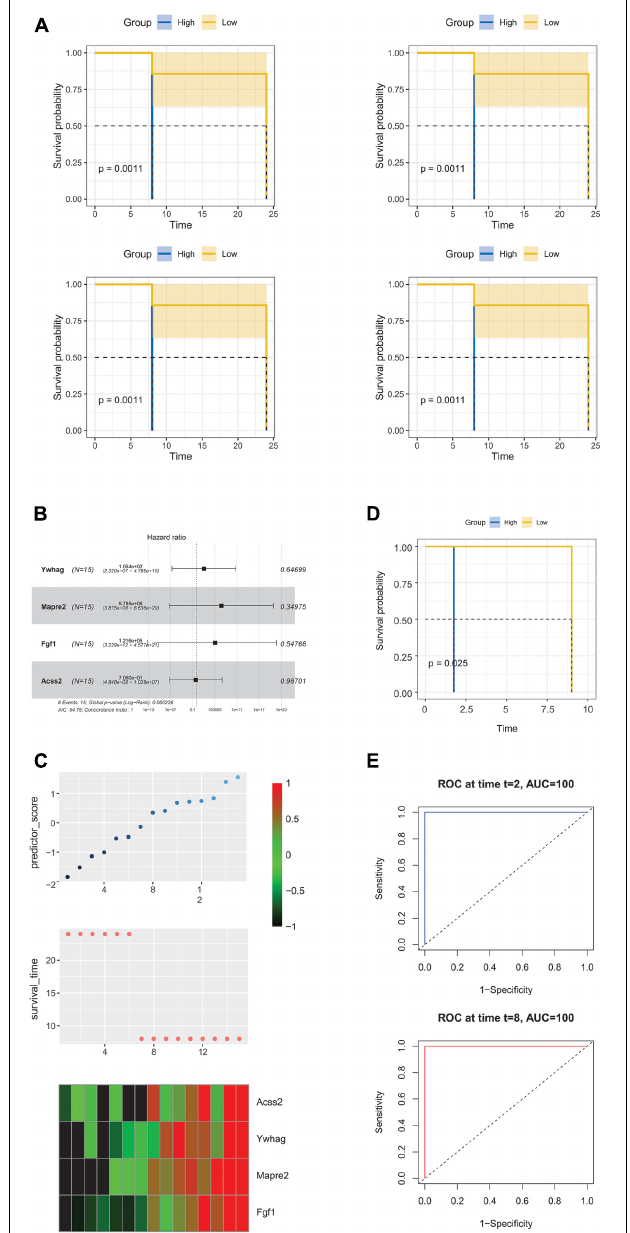
FIGURE 8 | Prognostic value of the hearing loss-related genes in presbycusis. (A) KM curve of overall survival (OS) prognosis of four genes in GES49543. (B) Forest map of OS multivariate analysis of four genes in presbycusis. (C) Top: the risk score of prediction model in validation set; Middle: corresponding survival status of each sample; Bottom: the mRNA expression of four signature genes in each sample. (D) KM curve of overall survival (OS) prognosis in GES6045. (E) ROC curve and AUC of prognostic model in